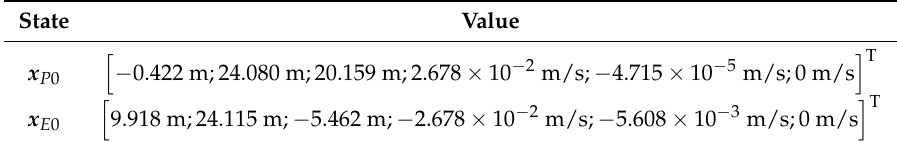
Table 1. Initial states of the pursuer and the